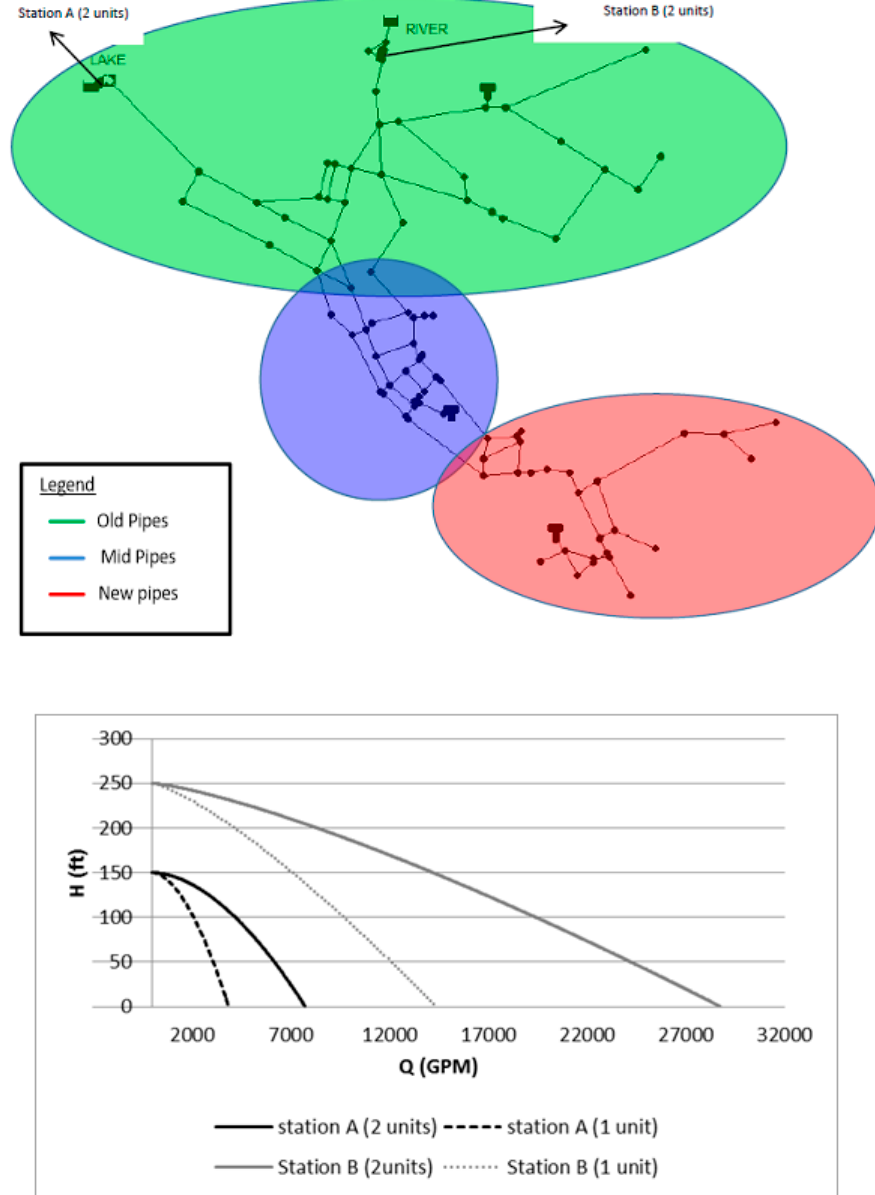
Figure 10. EPANET example 3-b, with pipe partition and pump stations’ curves. Table 3. Values of α i and β i for net 3-b (the assumption is that the calibration has already been done). Pipe Group Parameter Solution Old (Green)